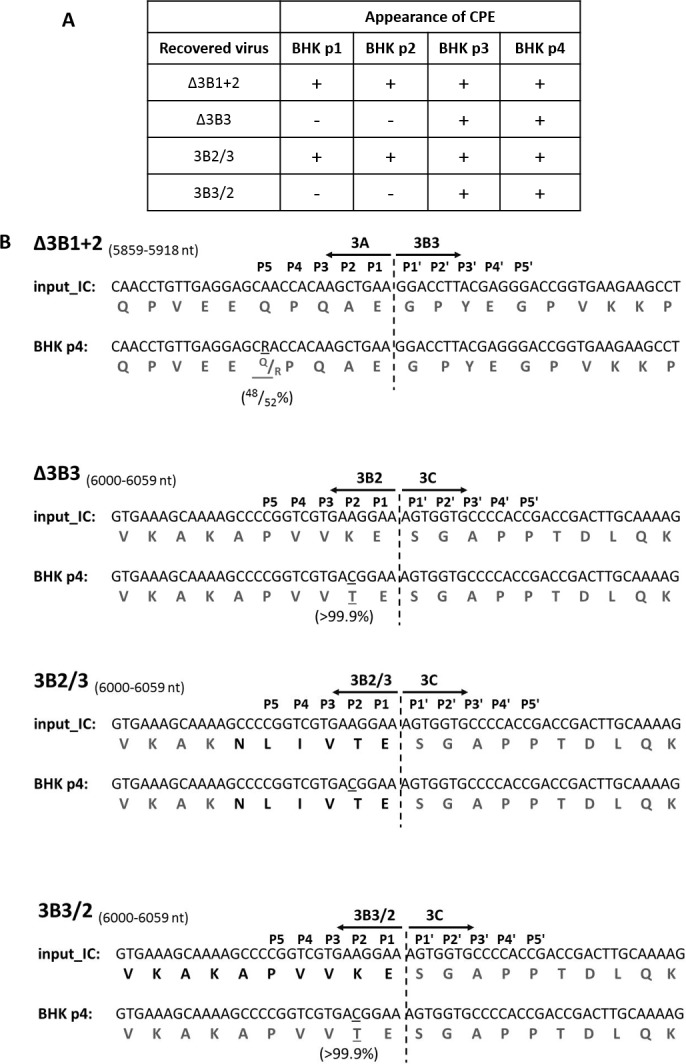
O1 Kaufbeuren virus containing Δ3B3 mutation changes 3B2-3C cleavage site to resemble 3B3-3C boundary.(A) Δ3B1+2, Δ3B3, 3B2/3 and 3B3/2 replicons were converted into infectious copy (IC) constructs by insertion of the capsid encoding region of O1 Kaufbeuren (O1K) FMDV isolate. RNA transcribed from IC constructs was transfected into BHK-21 cells and virus was recovered by freeze/thawing. Recovered viruses were blindly passaged up to four times in BHK-21 cells (BHK p1-4); each time infected cells were monitored for appearance of CPE. (B) All four viruses which had undergone four passages (BHK p4) were sequenced using Illumina MiSeq platform. Consensus and subconsensus sequences of recovered viruses (BHK p4) were compared to the input IC construct (input_IC). Part of sequences (nucleotide in black and amino acid in dark grey) where changes in recovered viruses were observed in comparison to input IC construct are shown. Mutated nucleotides/amino acids are underlined; percentage of virus population bearing the mutation is shown underneath in brackets. Dashed line indicates the scissile bond dipeptide cleavage site with the flanking boundary residues indicated and designated P5 to P5' and according to the standard nomenclature. Nucleotide range shown in brackets indicates position of the presented sequence in relation to genome of recovered viruses.